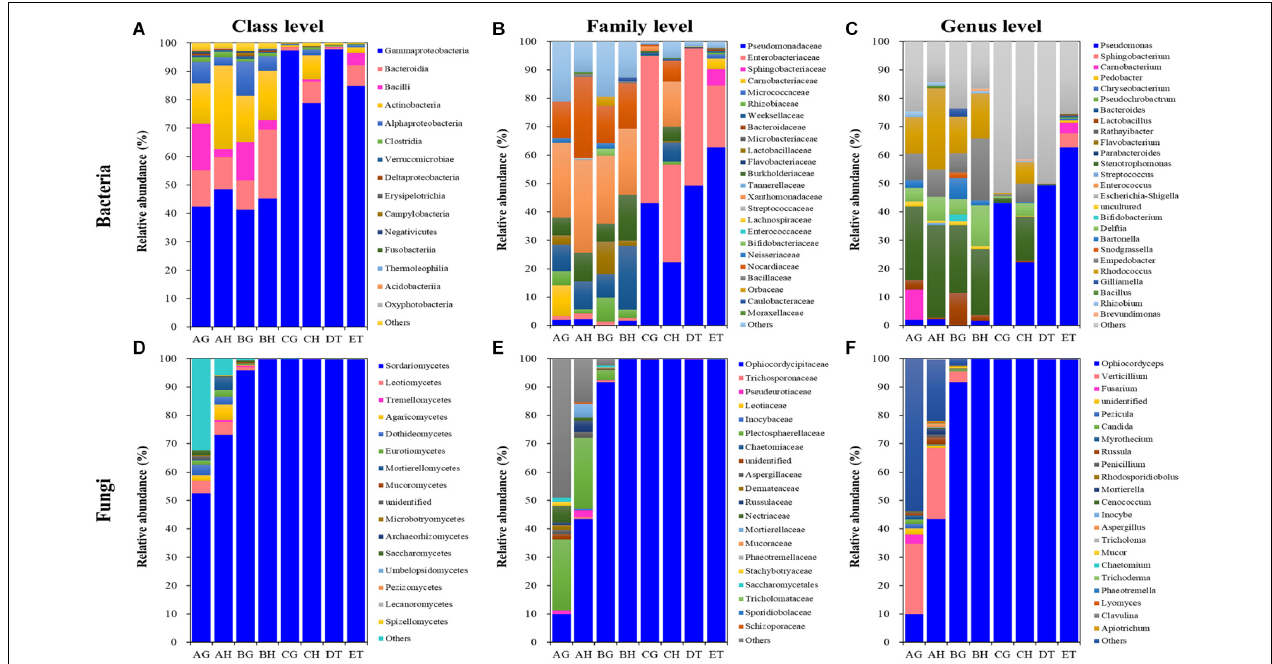
FIGURE 5 | Relative abundances of the top 10 bacterial (A–C) and fungal (D–F) classes (A,D) , families (B,E) and genera (C,F) in eight types of samples (AG, AH, BG, BH, CG, CH, DT, and ET). “Others” includes classes, families or genera beyond the top 10. AH and AG, hemolymph and guts of un-injected living larvae; BH and BG, hemolymph and guts of living larvae with high blastospore load; CH and CG, freshly mummifying larvae without mycelia coating; DT, tissues of the mummified larvae coated with mycelia; ET, tissues of the completely mummified larvae with